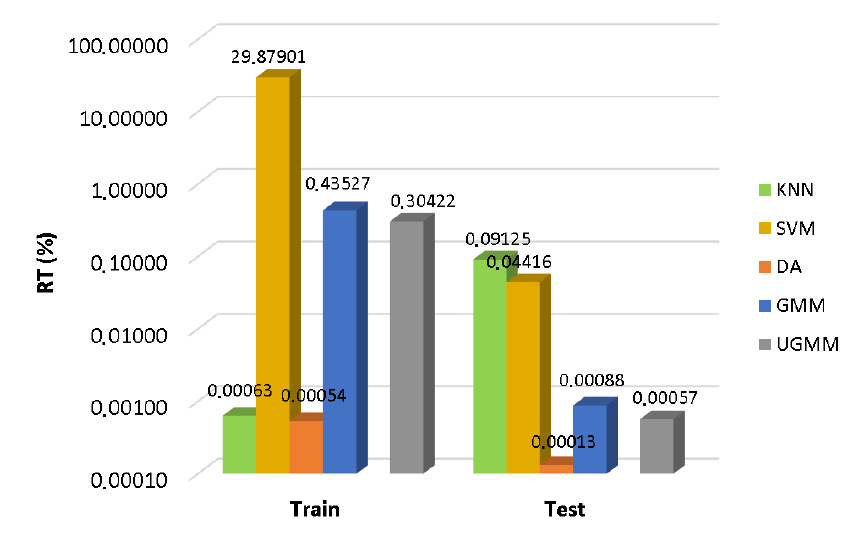
Figure 3. Computational cost comparison among the considered machine learning